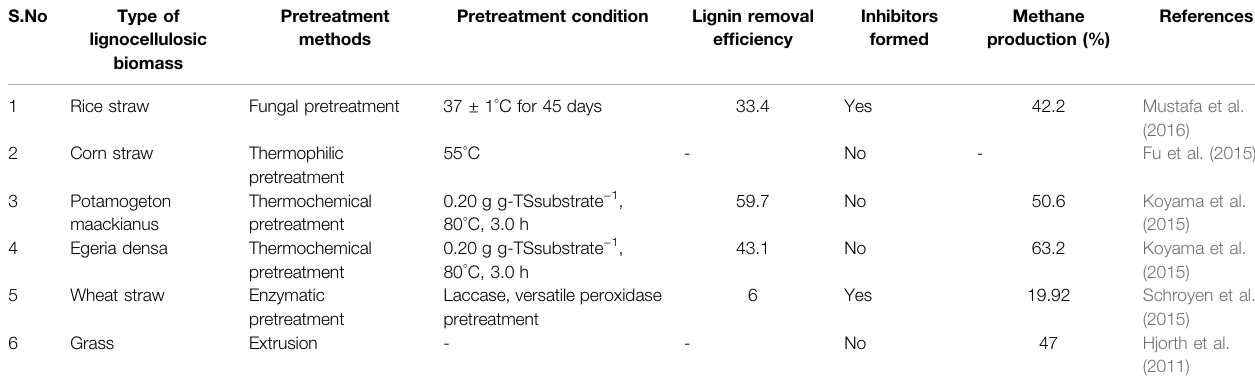
TABLE 2 | Effect of various pretreatments on the lignocellulosic biomass.